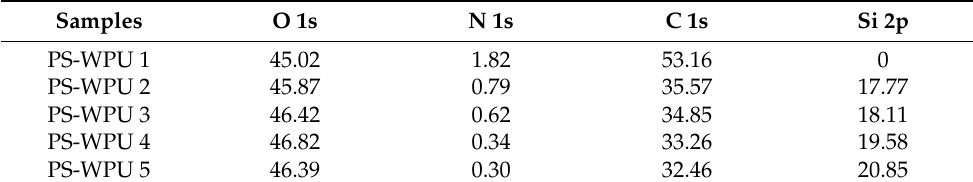
Figure 4. ( a ) XPS spectra and ( b ) Si 2p XPS spectra of the PS-WPU samples. Figure 3. ( a ) XPS spectra and ( b ) Si 2p XPS spectra of the PS-WPU samples. Table 3. Atomic relative concentration of elements in PS-WPU samples.